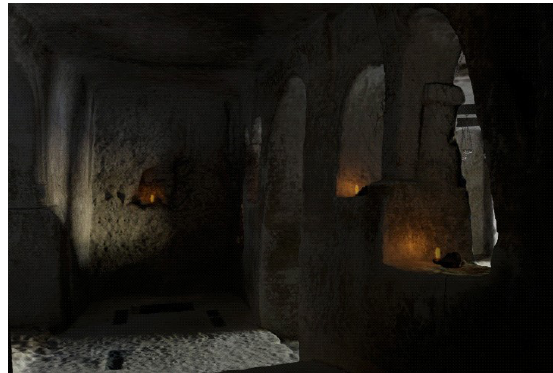
Figure 18: 3D Studio Max Sw. Photorealistic render of the nave with the chandelier with 12 glass little cups. h 17:00 p.m. - Date: 21 Dec. 2018